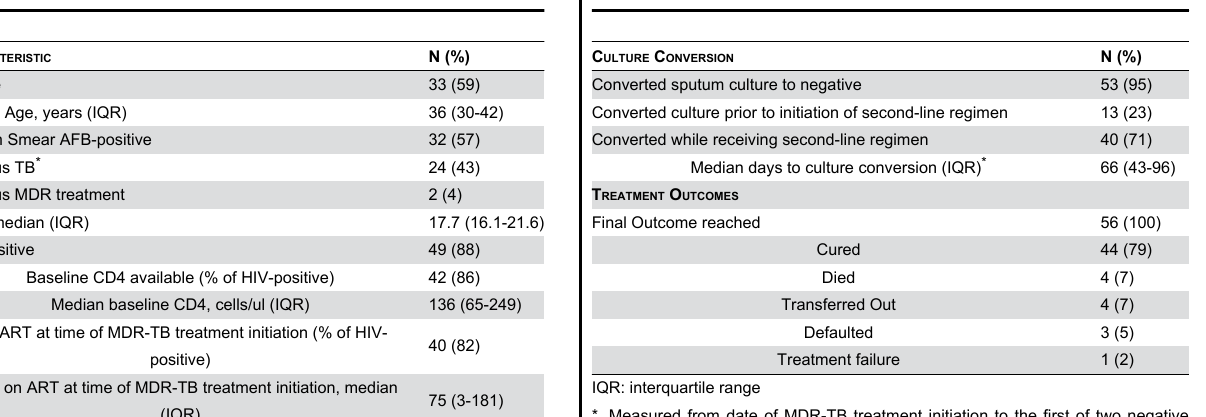
Table 1. Patient baseline characteristics (n=56).